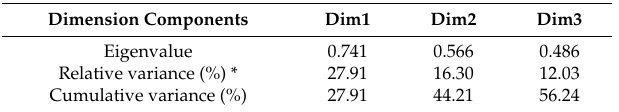
Table 4. Eigenvalues, relative and cumulative percentage of total variance for systematic review meta-database with respect to the three-dimension components (Dim1, Dim2, and